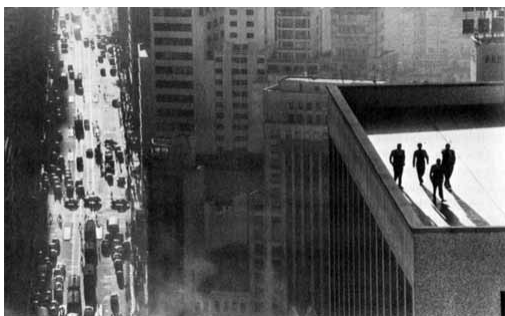
tinė su vaizdu į atriumą. a. novicko nuotr. Fig. 9. Stairway of the Palace of thelithuanian Cooperative union with an opening to the atrium space. a. novickas photo